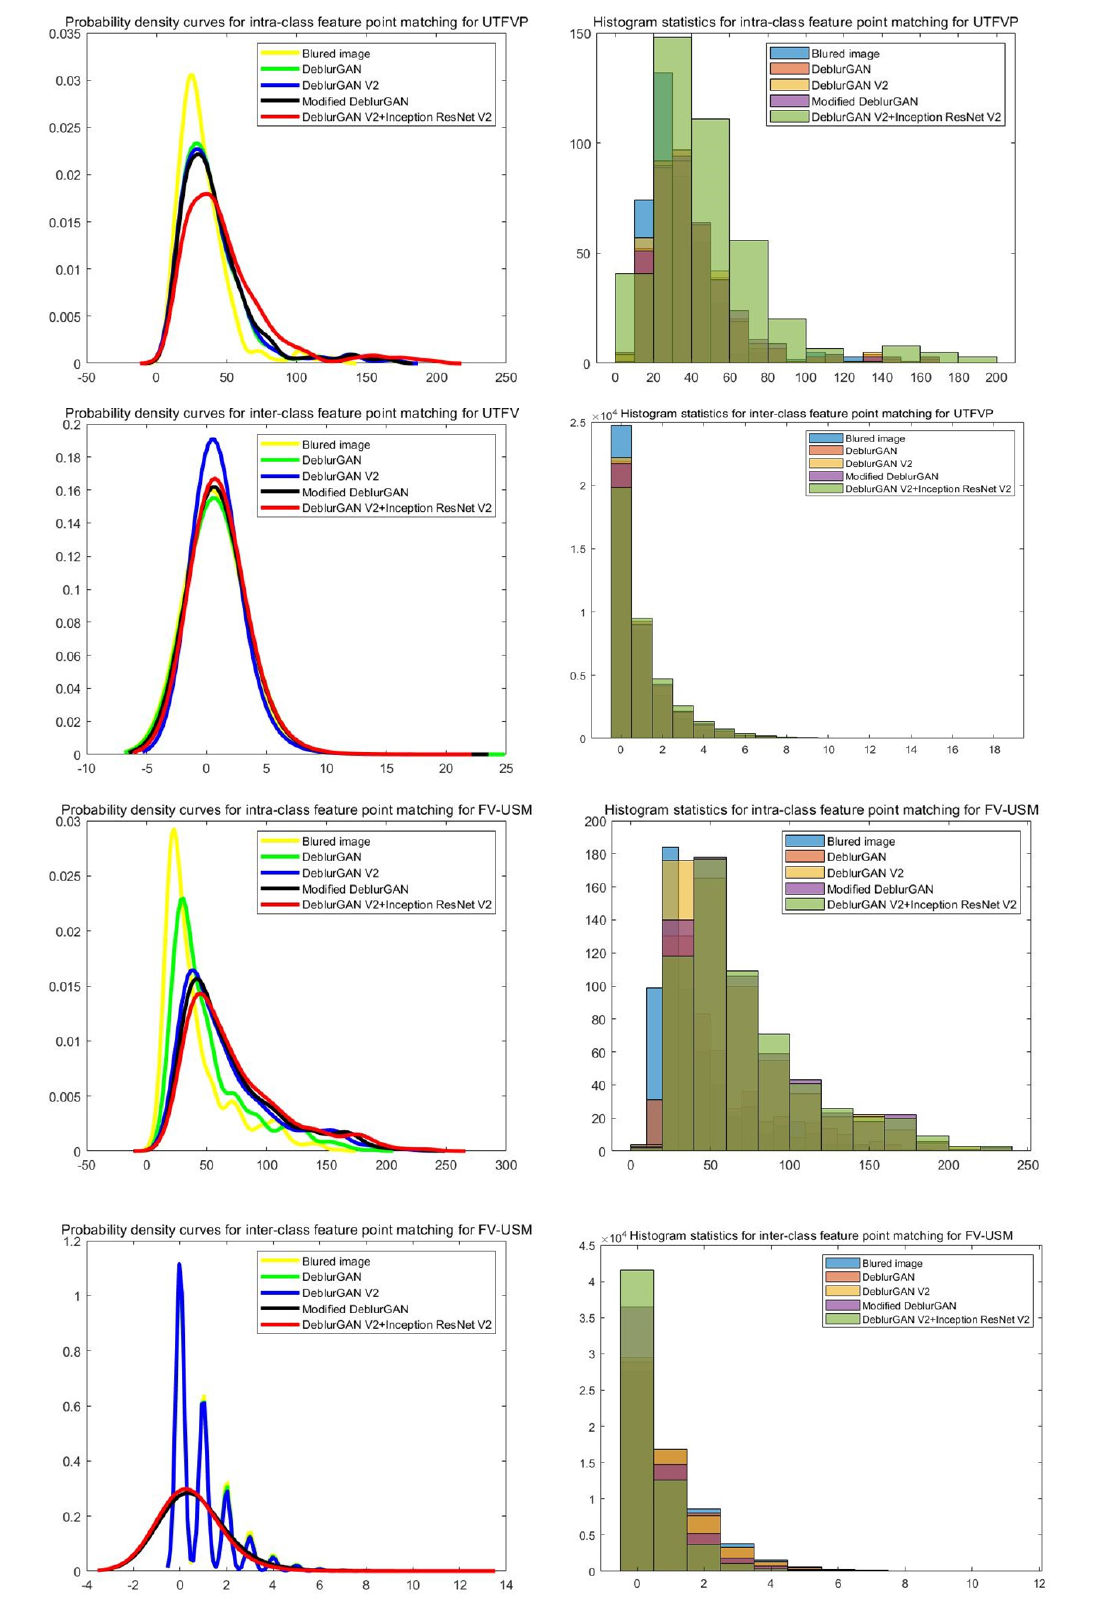
Figure 9. The intra-class and inter-class probability density distribution plots and feature point histogram statistical plots of various deblurring methods on the UTFVP and FV-USM